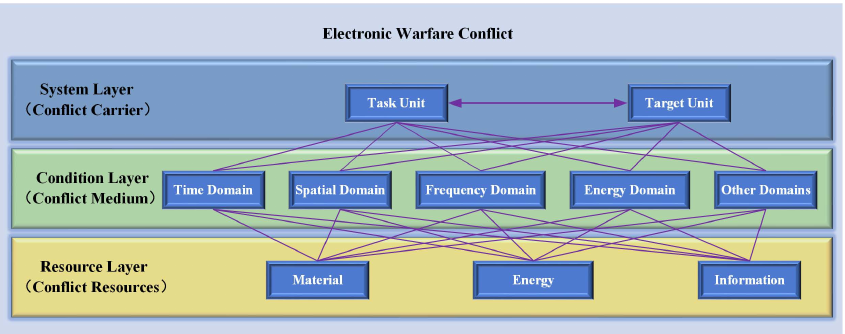
Figure 1. The hierarchical conflict structure corresponding to Electronic Warfare (EW)